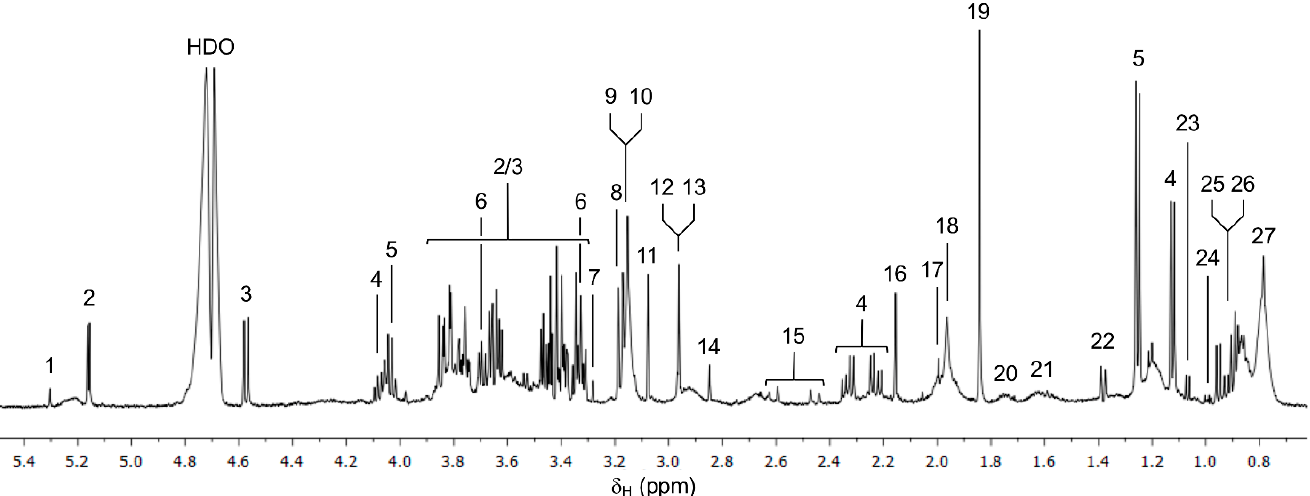
Figure 1. Representative 1 H NMR spectrum of a dairy cow serum sample. The signals corresponding to allantoine (1), α -glucose (2), β -glucose (3), BHB (4), lactate (5), myo-inositol (6), TMAO (7), betaine (8), phosphocholine (9), glycerol- phosphocholine (10), choline (11), creatinine (12), creatine (13), TMA (14), citrate (15), acetone (16), O -acetylglycoprotein (17), N -acetylglycoprotein (18), acetate (19), citrulline (20), lysine (21), alanine (22), valine (23), isobutyrate (24), isoleucine (25), leucine (26), and L1 lipoprotein (27) are annotated.